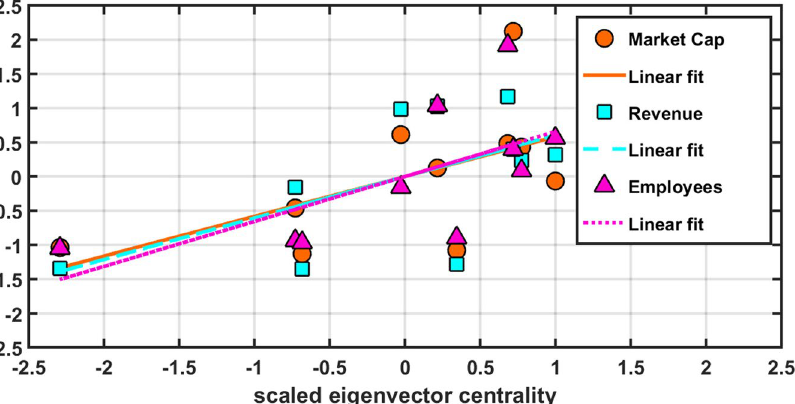
Figure 5. Results for USA: Linear regressions of scaled eigenvector centrality with scaled market capitalization (orange filled circles), scaled revenue (cyan filled squares), and scaled number of employees (magenta filled up- triangles). The best fits (linear regressions) are plotted as lines for market capitalization (orange solid), revenue (cyan long dashed) and employees (magenta short